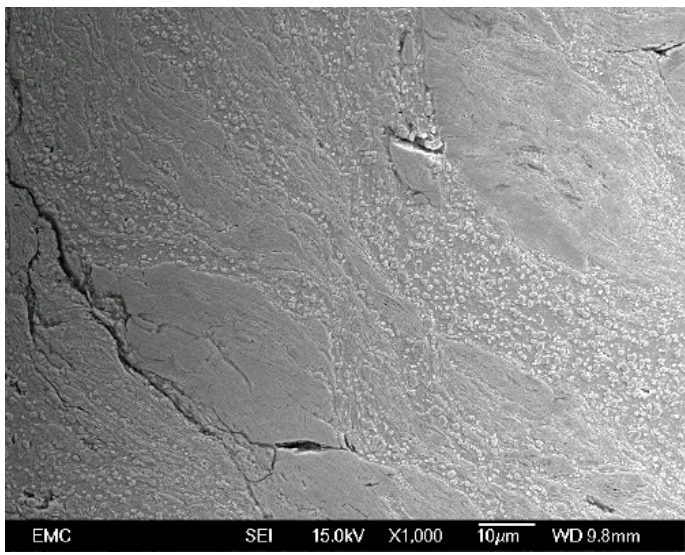
Figure 12. Cracks in WEAs.